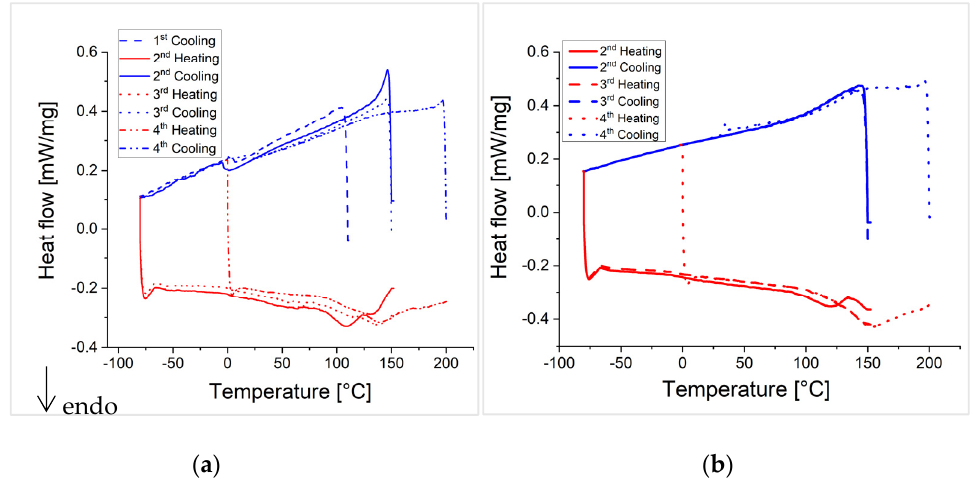
Figure 9. DSC heating (red) and cooling (blue) curves of the crosslinked P(BA 60 - co -FMA 40 ) 10 . ( a ) Crosslinked P(BA 60 - co -FMA 40 ) 10 with BMI in a motif ratio of 1:1. The endothermic peak indicates the retro-Diels-Alder reaction at around 90 °C in all three heating curves. ( b ) Crosslinked P(BA 60 - co -FMA 40 ) 10 with P(MMA 74 - co -MIMA 26 ) 9 . The endothermic peak indicates the retro-Diels-Alder reaction starting at around 100 °C in the third and fourth heating curve.